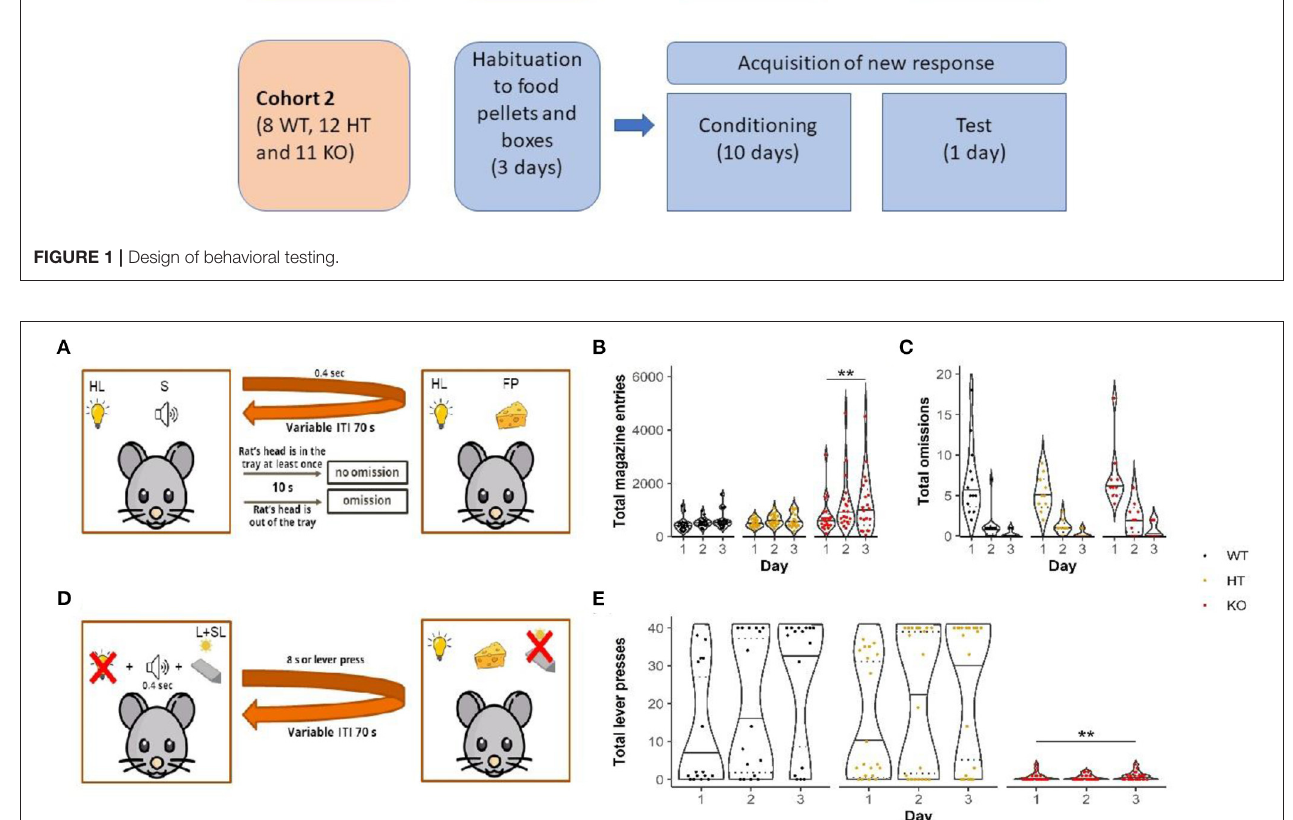
FIGURE 2 | Conditional magazine approach task (A) revealed elevation in appetitive behavior indicated as more magazine entries made by mutants (B) without affecting conditioning (number of omissions) (C) . In the Pavlovian/instrumental autoshaping procedure, (D) DAT-KO rats displayed pronounced impairments demonstrated by significantly reduced number of lever presses (E) . Data are represented as violin plots with median (solid line) and 25 th and 75 th percentiles (dotted lines) and points indicating each value. HL, house light; S, sound; FP, food pellet; ITI, intertrial interval; L + SL, lever + signal light; ** p < 0.01, Dunn’s